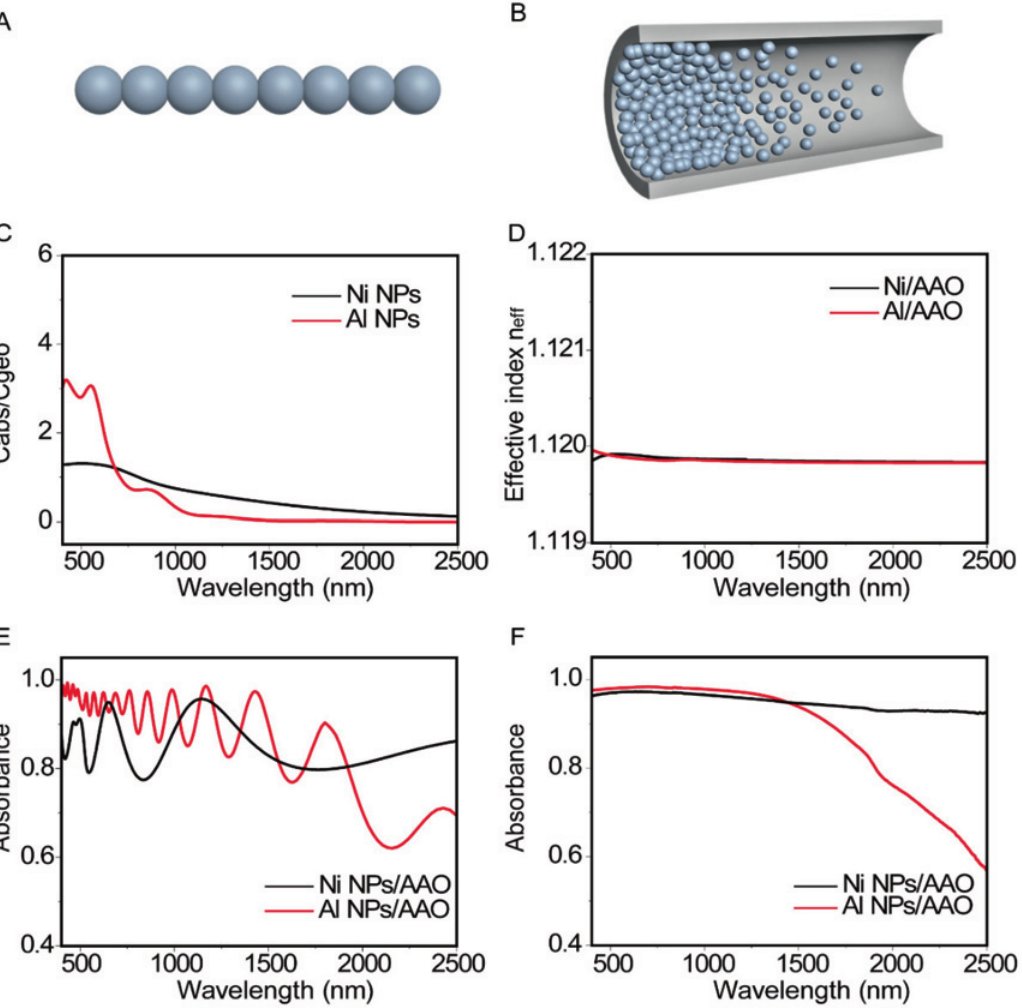
Figure 3: (A) Representative configuration of the close packed Ni NPs assembly with N =8. The diameter of Ni particle is set as 24 nm. (B) Schematic pro fi le of the highly porous and low fi lling ratio Ni NPs in AAO nanochannels. The porosity is ∼ 60% and fi lling of metal particle is ∼ 0.1%. (C) Calculated absorption cross section of (A) as normalized by the geometry cross section. (D) Calculated effective refractive index